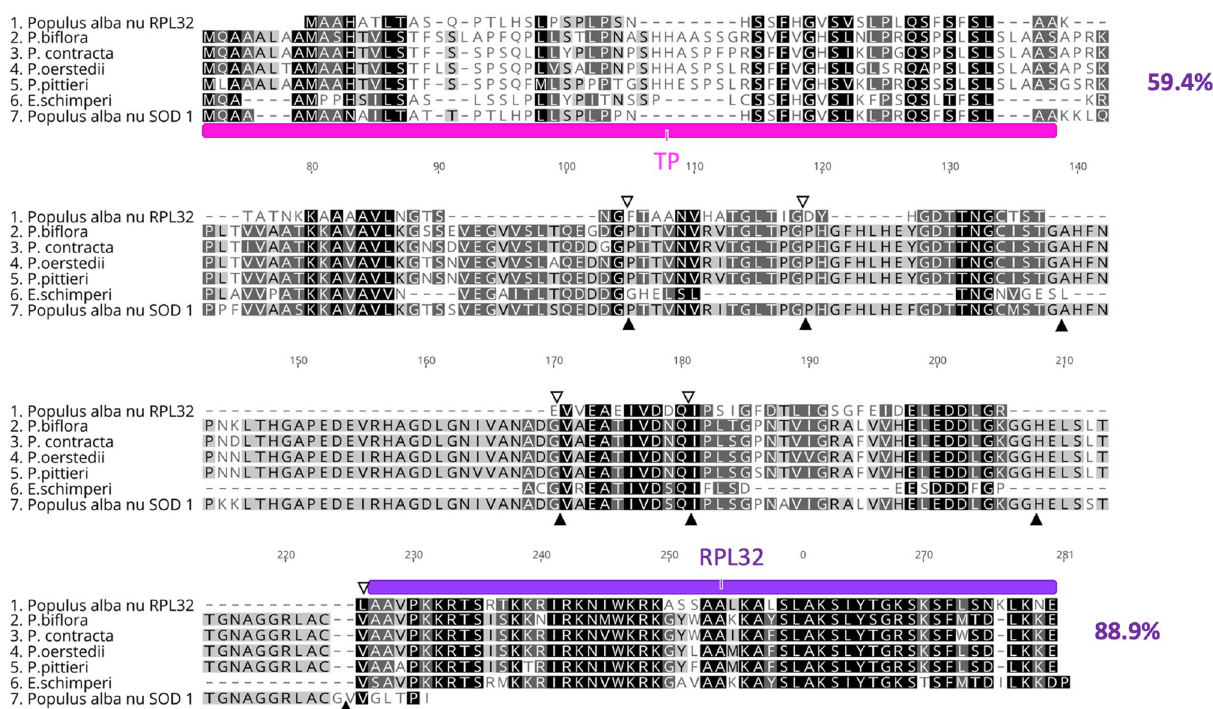
Figure 2. Alignment of the amino acids of nuclear RPL32 of Euphorbia schimperi, Populus alba (BAF80584.1) , Passiflora biflora ; (QKY65178.1) , P. contracta ; (QKY65180.1) , P. oerstedii ; (QKY65177.1) and P. pittieri ; (QKY65179.1) and Populus alba nuclear SOD-1(BAF80585.1). Pink annotation indicates plastid transit peptide of SOD-1 in Populus . Purple annotation indicates a conserved domain of RPL32 in Populus . Open and filled triangles indicate the position of introns in the cp rpl32 and cp sod-1 genes in Populus (Ueda et al. 2007). Pairwise aa sequence identity of nuclear-encoded RPL32 from E. schimperi , Populus alba , Passiflora ( P . biflora, P. contracta, P. oerstedii and P. pittieri ) and nuclear-encoded SOD-1 of Populus alba was 59.4% and 88.9% for transit peptide and the ribosomal protein L32 conserved domain, respectively. Gaps are indicated by dashes.